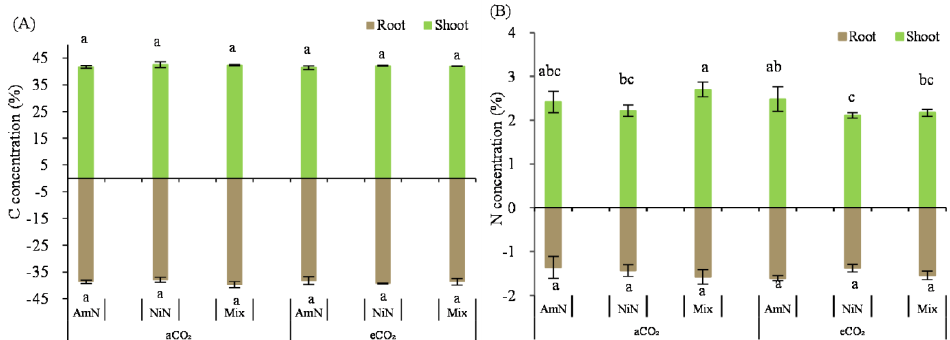
Figure 5. The carbon ( A ) and nitrogen ( B ) concentrations of wheat seedlings. Note: (1) AmN denotes Ammonium N, NiN denotes Nitrate N, Mix denotes Mixed N; (2) TC means total C concentration, TN means total N concentration; (3) aCO 2 denotes the ambient atmospheric CO 2 concentration at 390 µ mol/mol; eCO 2 denotes the enriched atmospheric CO 2 concentration at 690 µ mol/mol; standard deviation; (6) above- and belowground LSD are separate Table 8. Two − factor ANOVA analyses for C and N concentration in wheat seedlings.